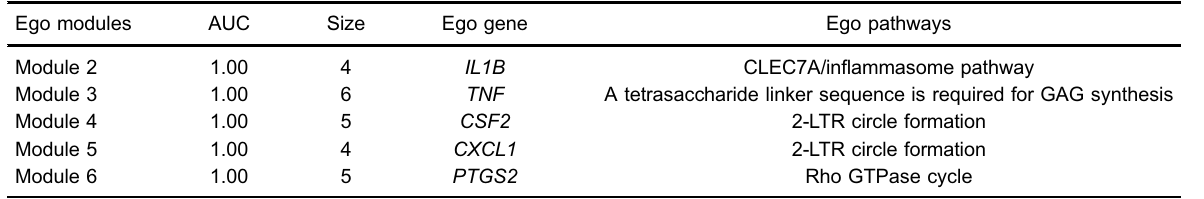
Table 1. Properties of ego genes, modules and pathways.